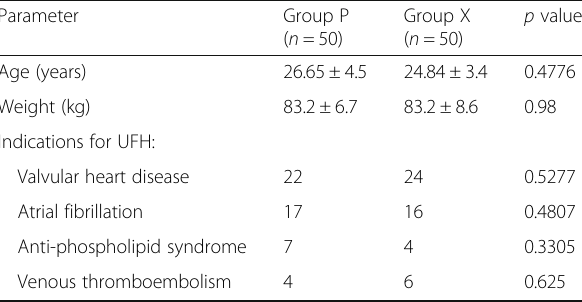
Table 3 Comparison between the two groups as regards the age (in years), weight (in kilograms), and indication for UFH